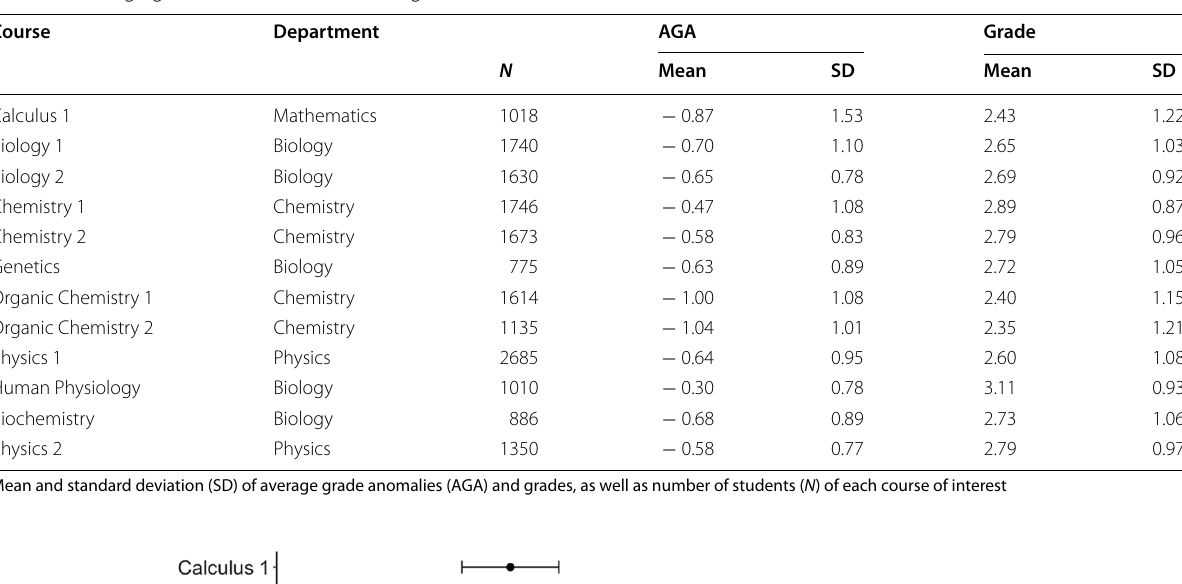
Table 3 Average grade anomalies (AGAs) and grades